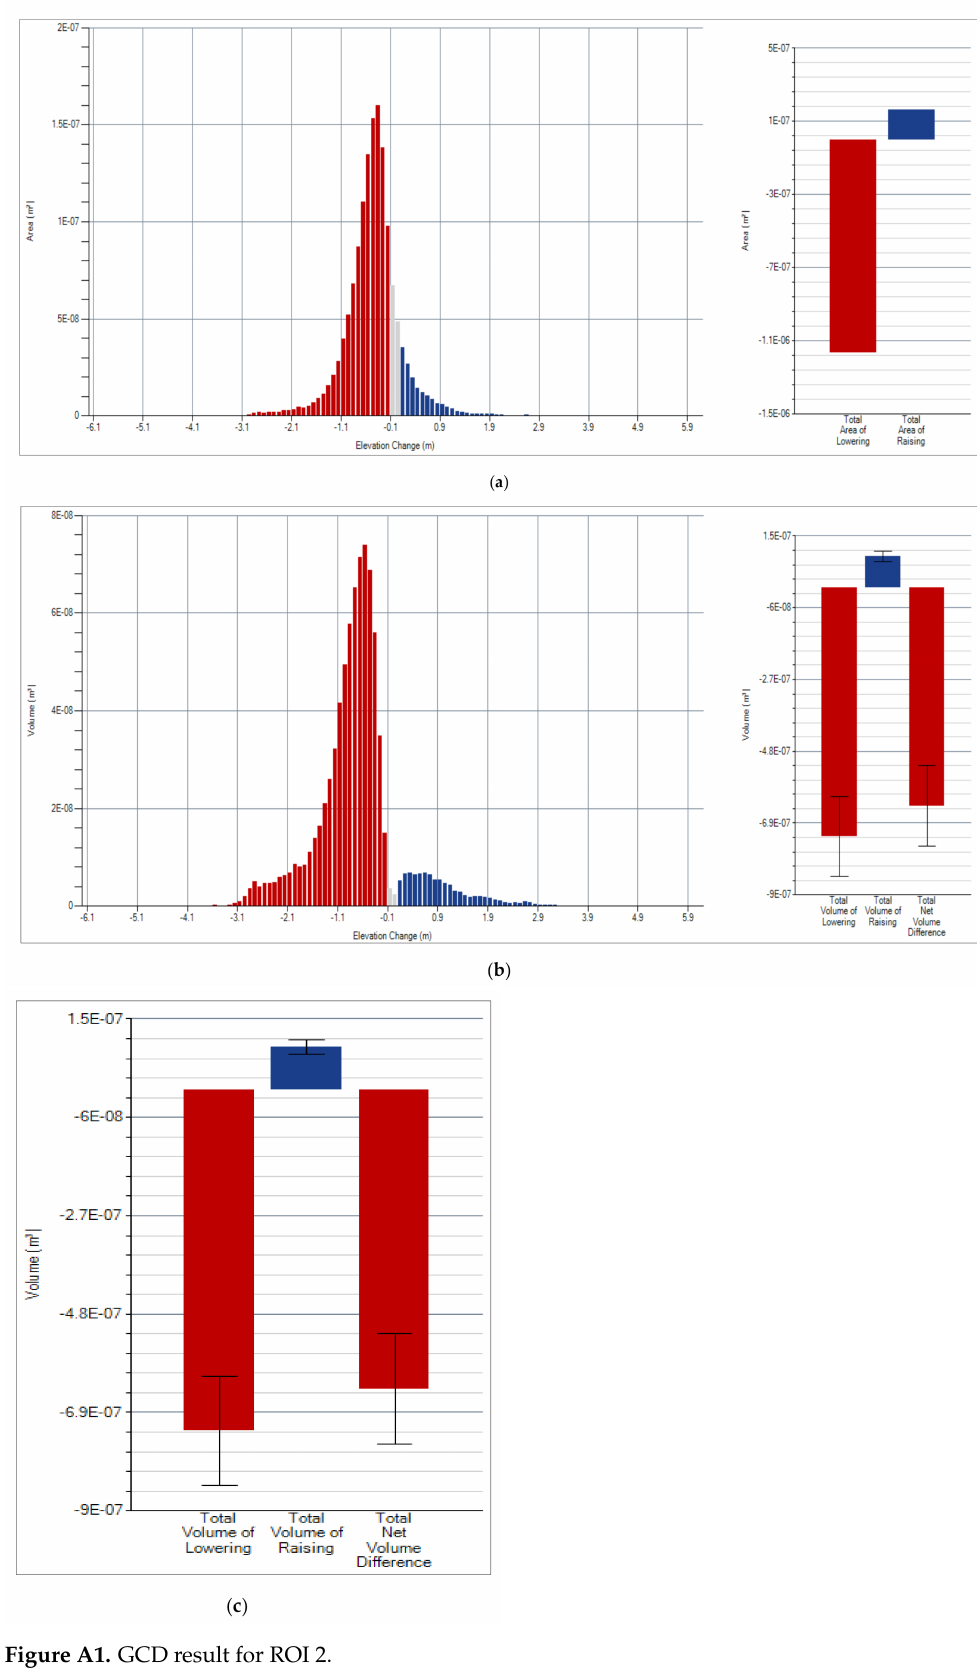
Figure A1. GCD result for ROI